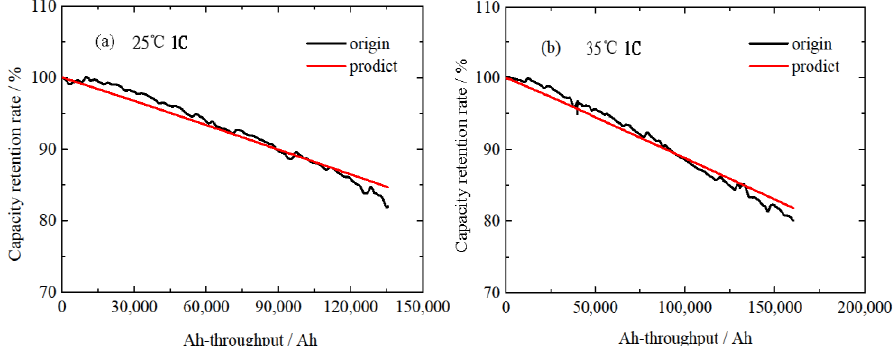
Figure 8. Accuracy validation results of the final improved model 23 under two conditions: ( a ) 25 °C,1 C, and ( b ) 35 °C,1 C.